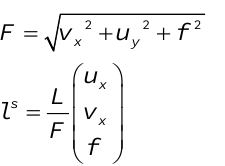
Figure 1: The orientation of the sensor frame ( S frame) relative to the inertial coordinate frame ( I frame). The sensor frame ( S ) - The origin of the s frame is at the optical centre of the camera with geodetic coordinates. The z axis is along the general downward direction along the optical axis. The x axis is to the right hand side of the image .The y axis completes the right-handed coordinate frame. The image points and normalized image points are expressed in the S frame ( u x , v x , f ). Using similar triangles in Fig.